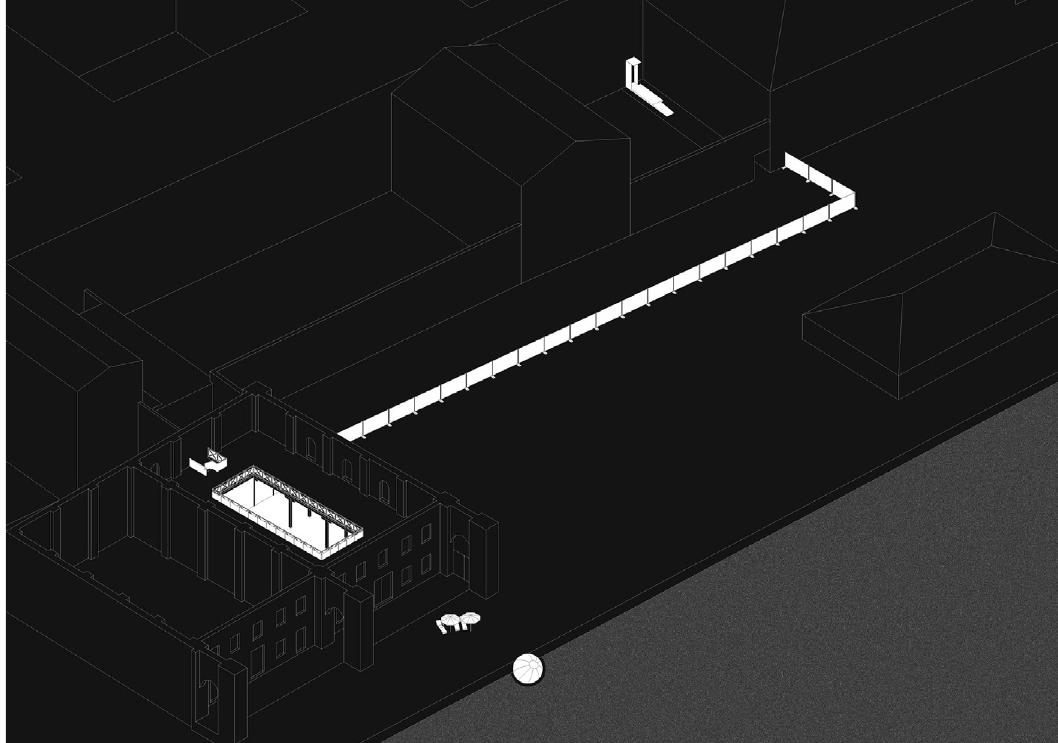
Figure 4. The Navy spaces dedicated to the exhibition route for the opera “Sun & Sea: Marina” in 2019